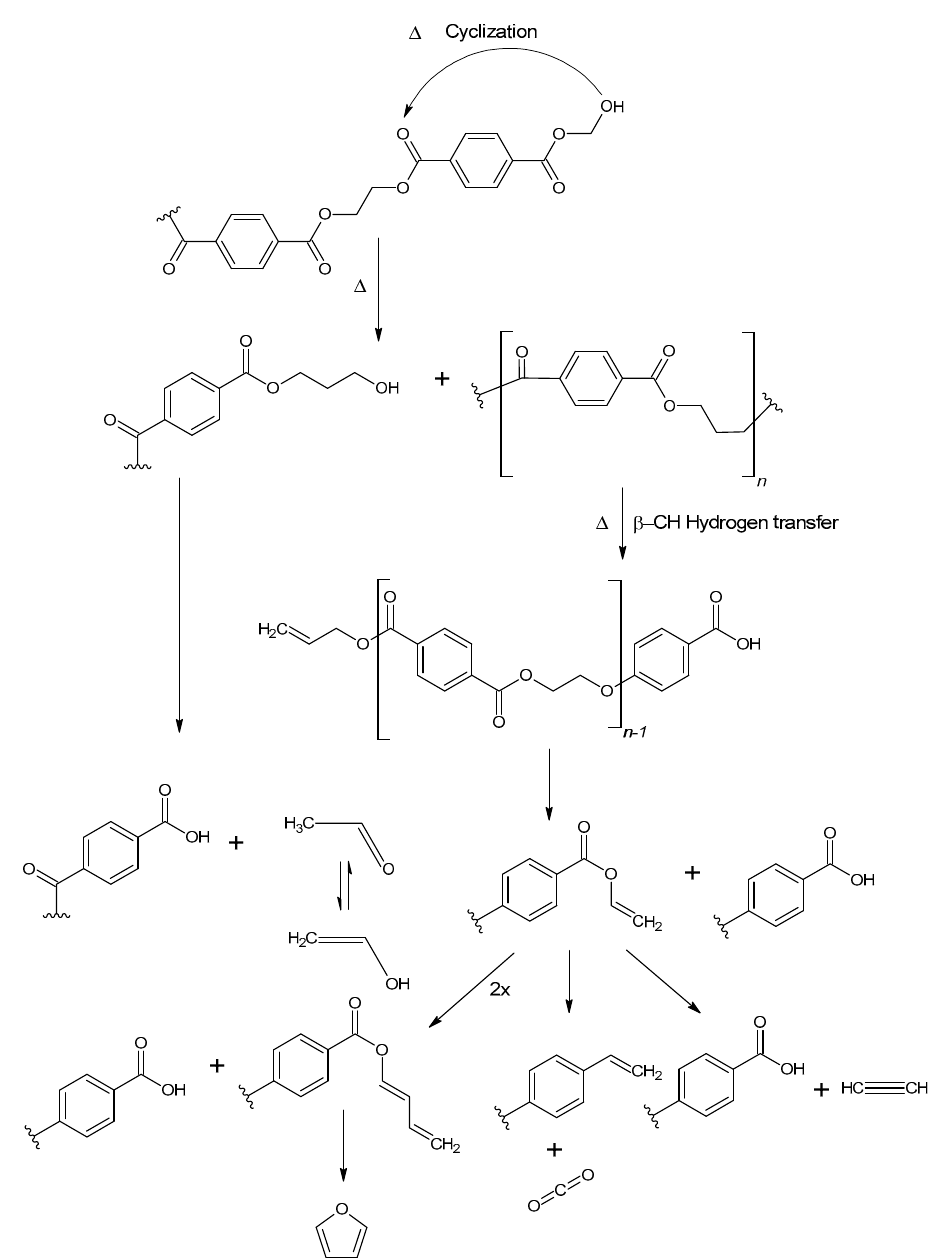
Figure 3. Thermal degradation reactions of PET (based on [65]).